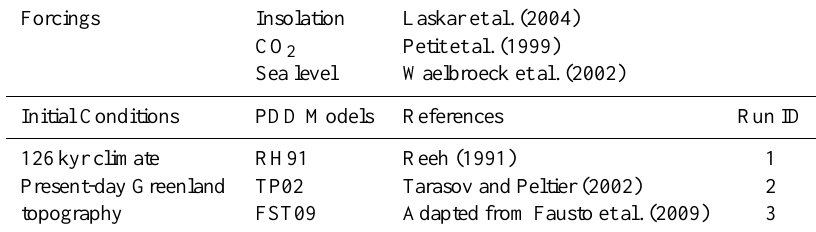
Table 1. Standard fully coupled CLIMBER-GRISLI